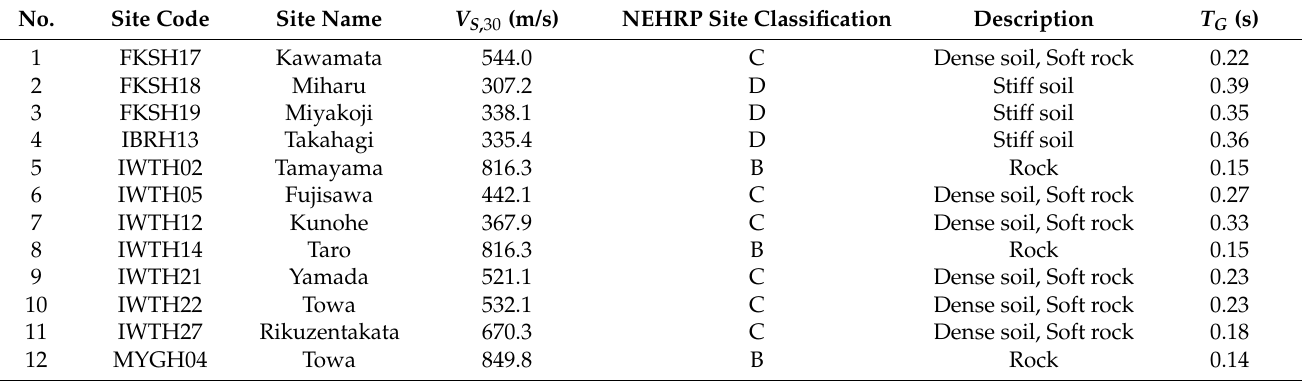
Table 1. Information of the